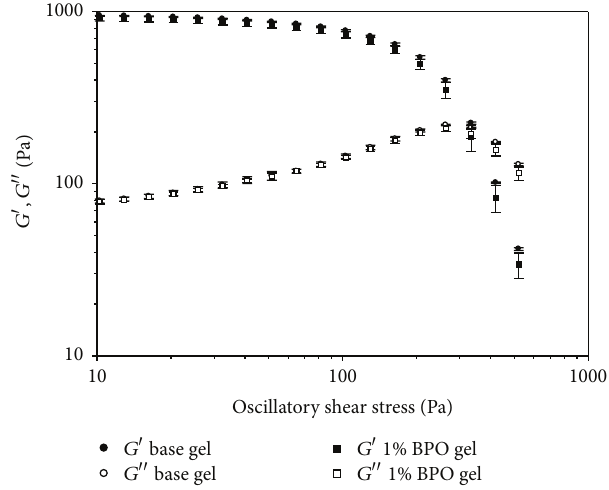
Figure 6: Storage modulus ( 𝐺 󸀠 ) and loss modulus ( 𝐺 󸀠󸀠 ) as a function of oscillatory shear stress (Pa) on the base gel and 1% BPO gel. Experiment was conducted in triplicate. Mean values and standard deviations of three experiments are shown.